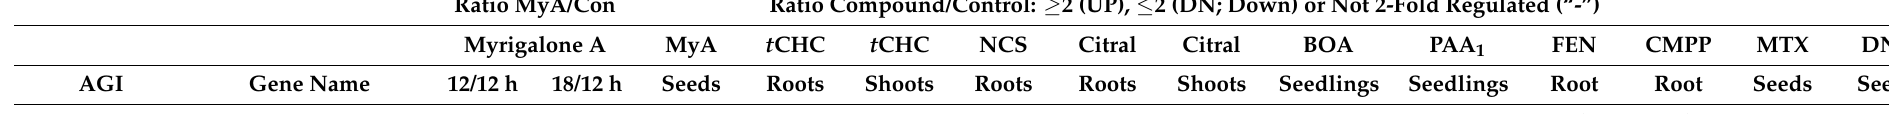
Table 3. Comparison of compound treatment on the expression of auxin signalling and hormone transporter genes. Results from myrigalone A (MyA) treated germinating Lepidium sativum seeds were compared to seeds, seedlings or root cultures of Arabidopsis thaliana treated with the allelochemicals trans -chalcone ( t CHC), narciclasine (NCS), citral, benzoxazolin-2( 3H )-one (BOA), or with the oxylipin A 1 -phytoprostane (PPA 1 ), the herbicide safeners fenclorim (FEN) or CMMP, or with methotrexate (MTX) or 2,4-dinitrophenol (DNP). Transcript abundance ratios compound/control ≥ 2 or ≤ 0.5 were considered as UP or DOWN (DN), respectively, or otherwise labelled as not at least 2-fold regulated (“-”). See Figures S1 and S2 for chemical structure. Published transcriptomes: t CHC [19], citral [18], BOA [4], published lists of at least 2-fold regulated DEGs were used; for FEN and CMMP, the lists used were at least 2-fold regulated DEGs. “n.a.”, gene not available in sequenced transcript